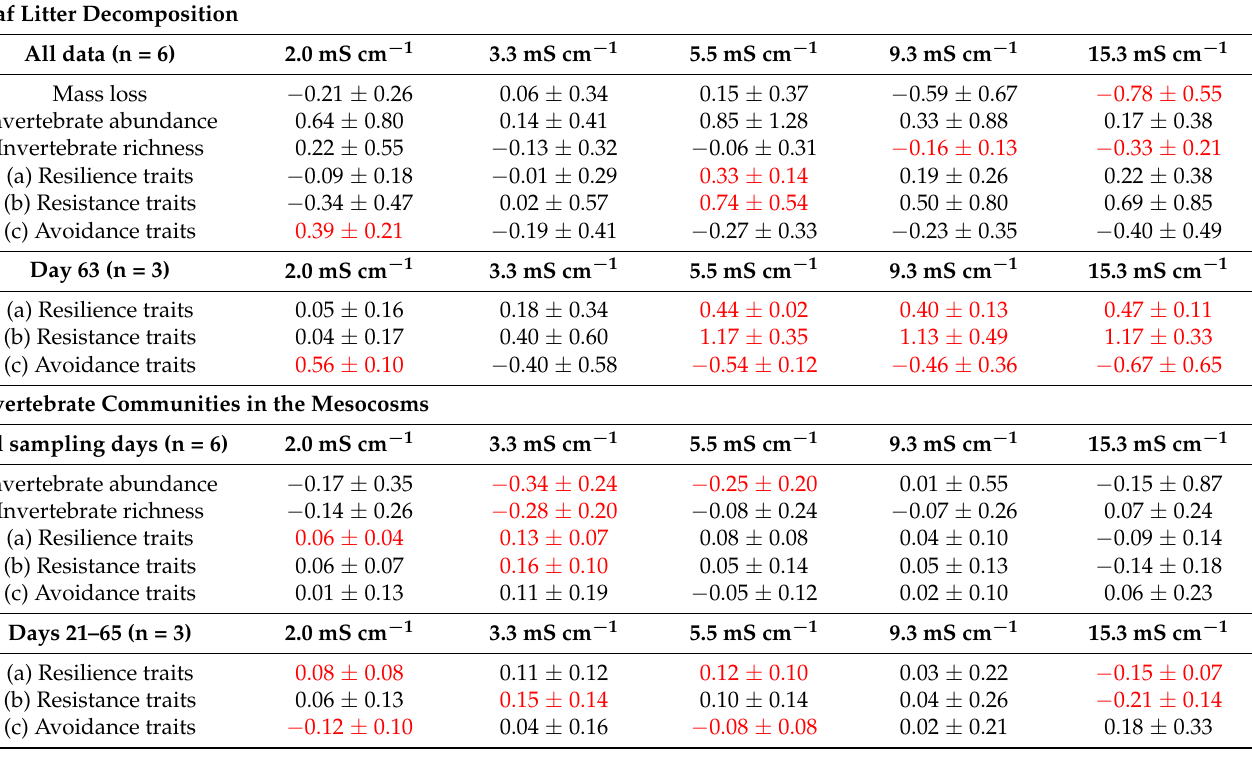
Table 2. Average deviation ± 95% confidence limits of values in a treatment in relation to the control for the response variables of the leaf litter decomposition experiment and for the invertebrate communities in the mesocosms. Values in red represent a net (negative or positive) effect of a given salinity value on the response variable. Proportion of invertebrates with (a) short lifespan, ovoviviparous reproduction, and aerial respiration, (b) more than one generation per year, and (c) non-aquatic life stages and terrestrial